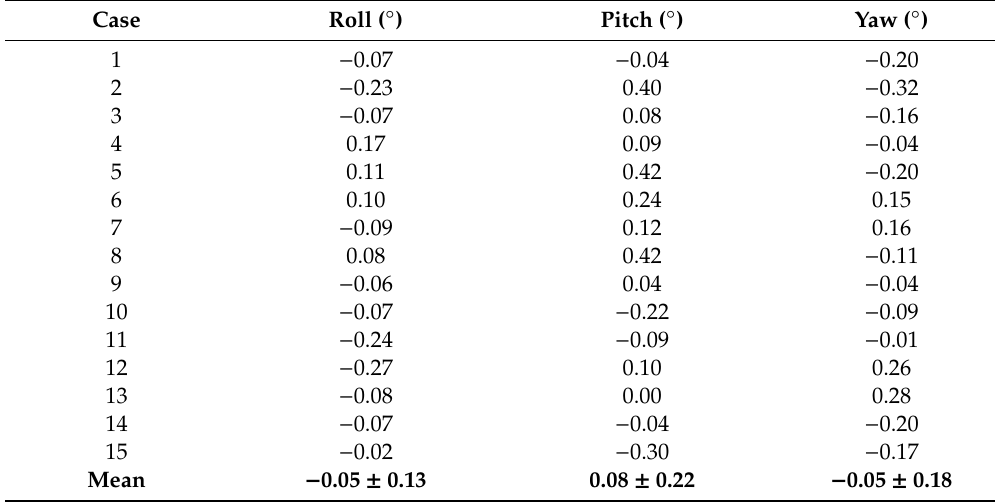
Table 1. The angle di ff erence ( ◦ ) between the true and calculated rotations in the roll, pitch, and yaw directions (mean ±